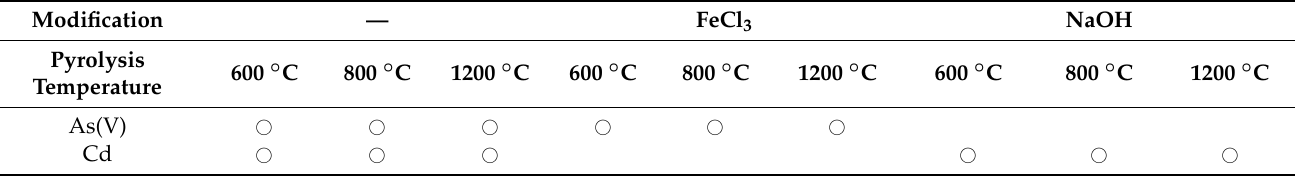
Table 1. Summary of experimental conditions for As(V) and Cd adsorption experiments. FeCl 3